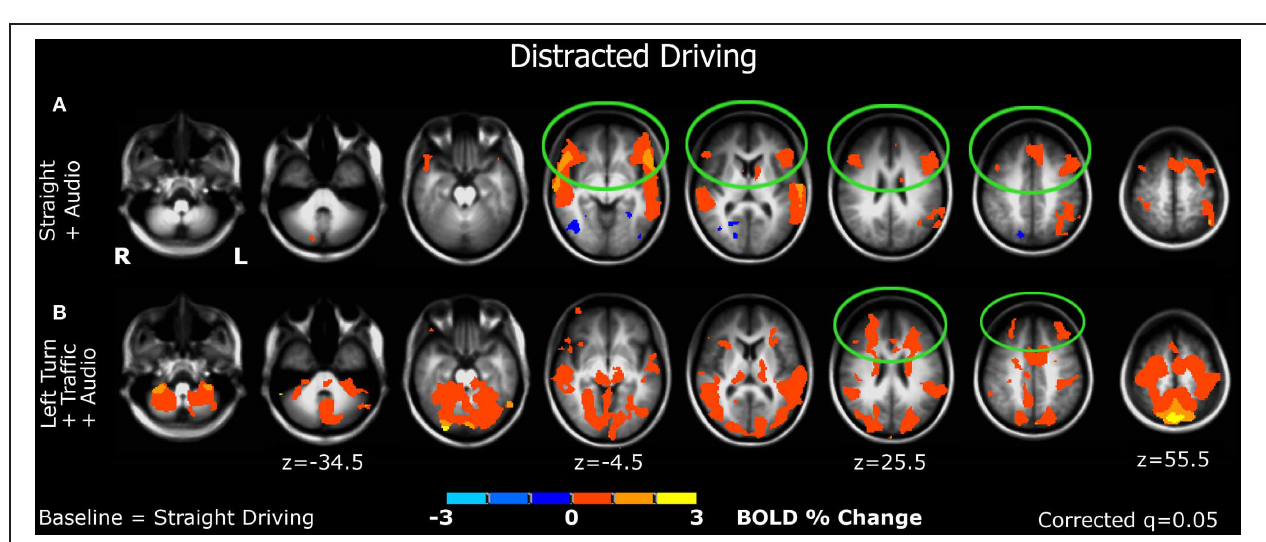
FIGURE 4 | Brain activations associated with distracted driving. (A) Straight driving with a cognitive-distraction, audio task. (B) The demanding, left-turn condition with oncoming traffic plus the cognitive distraction.